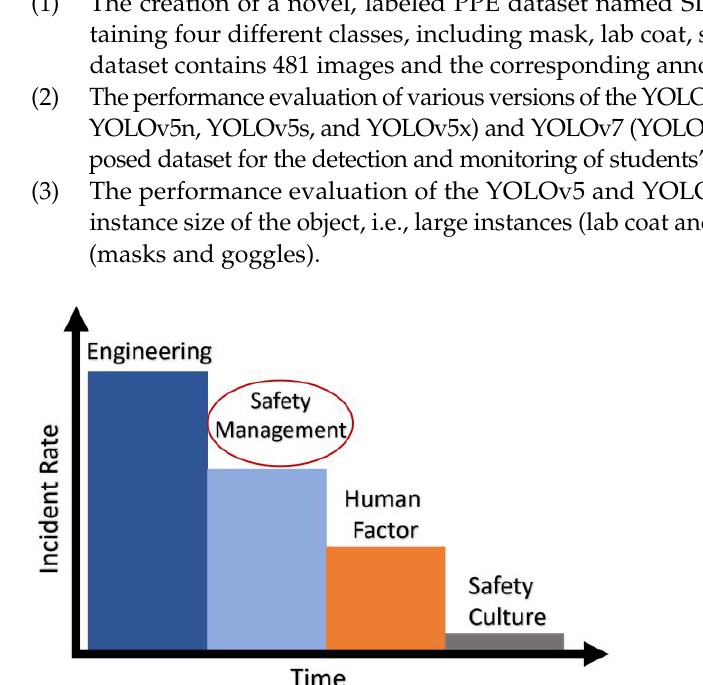
Figure 3. Sample images of Student Laboratory Safety (SLS) dataset.